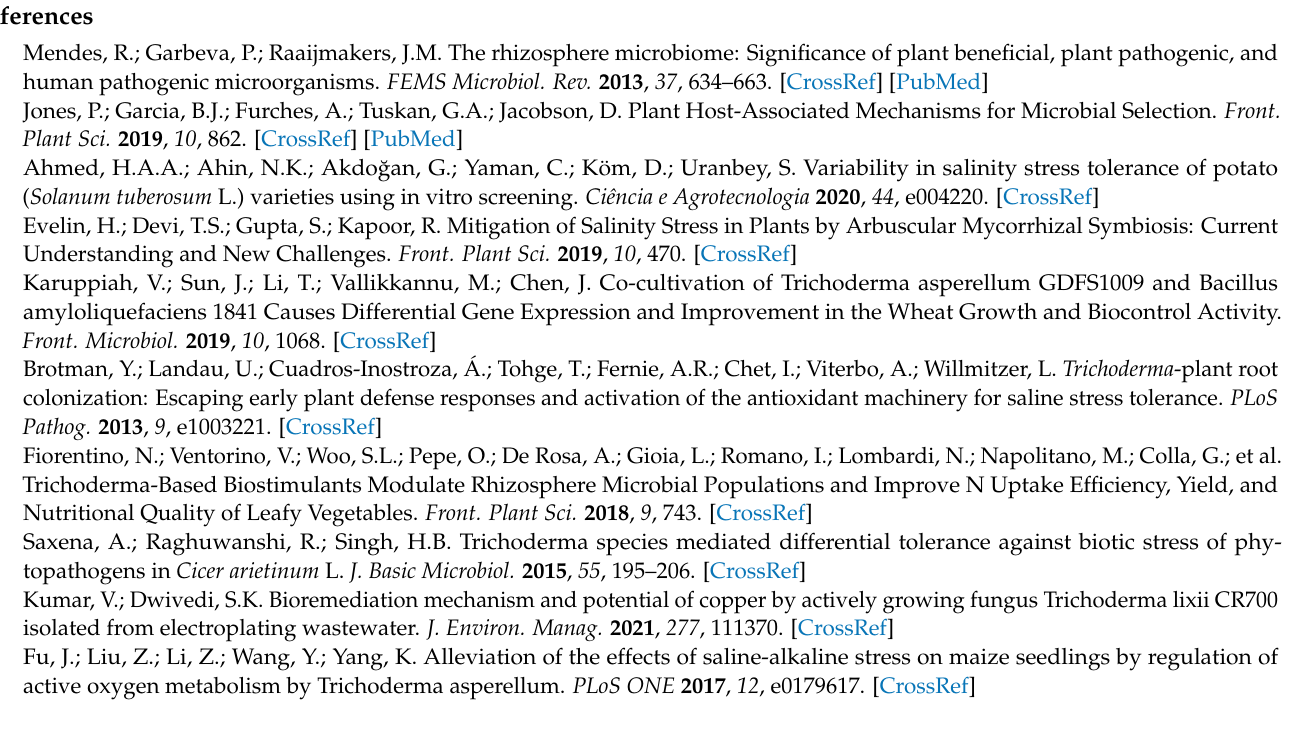
strains on the growth and Na+ mitigation of maize seedlings. Growth of maize under normal (A) and saline (B) conditions in hydroponics system. Shoot length (C), root length (D), shoot weight (E), root weight (F), sodium (G) and potassium (H) content under normal and saline conditions. Values are the average of five biological replicates. Error bars represent the standard error. Bars with different letters represent a statistically significant difference from each other at the level of p <0.05 based on the ANOVA. Figure S11. Growth of T. asperellum WT, OEVel1, OELae1, ∆ Vel1 and ∆ Lae1 in both normal and saline conditions at three different media. (A) Growth of T. asperellum WT and mutants were studied in PD medium supplemented with 250 mM, 500 mM, 1 M and 1.5 M KCl. (B) Growth of T. asperellum WT and mutants were studied in YM medium supplemented with 250 mM, 500 mM, 1 M and 1.5 M KCl. (C) Growth of T. asperellum WT and mutants were studied in VMS medium supplemented with 250 mM, 500 mM, 1 M and 1.5 M KCl. Figure S12. Growth of T. asperellum WT, OEVel1, OELae1, ∆ Vel1 and ∆ Lae1 in (A) YM Broth (B) YM Broth supplemented with 0.5 M NaCl and (C) YM Broth supplemented with 0.5 M KCl. Figure S13. sporulation of T. asperellum WT,